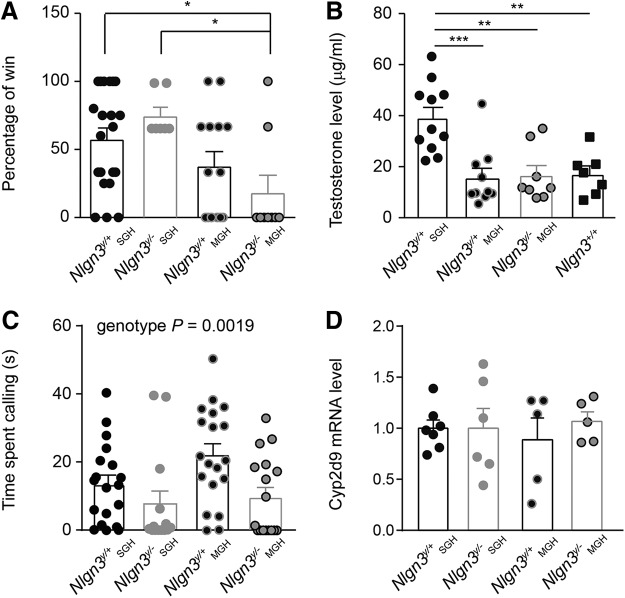
Decreased competitive behavior in adult (2- to 4-mo-old) Nlgn3y/– and Nlgn3y/+ mice from MGH. A, Nlgn3y/– mice from MGH were defeated more frequently than Nlgn3y/+ and Nlgn3y/
– mice from SGH when opposed to an unfamiliar submissive male in the tube test. B, Increased urinary testosterone levels in Nlgn3y/+ mice from SGH. C, Housing conditions did not modify the time Nlgn3y/+ or Nlgn3y/– mice spent calling a female in estrus. Regardless of the housing conditions, Nlgn3y/– mice spent less time calling a female in estrus than Nlgn3y/+ mice. Note that data from Fig. 2A were replotted here to allow comparison. D, Hepatic mRNA expression levels of Cyp2d9 were similar between mice in MGH and SGH. Values are represented as mean ± SEM. Statistical significance was tested by Kruskal–Wallis test and post hoc Tukey’s multiple comparison test (A and B) and one-way ANOVA and post hoc Tukey’s multiple comparison test (C and D). *P < 0.05; **P < 0.01; ***P < 0.001.